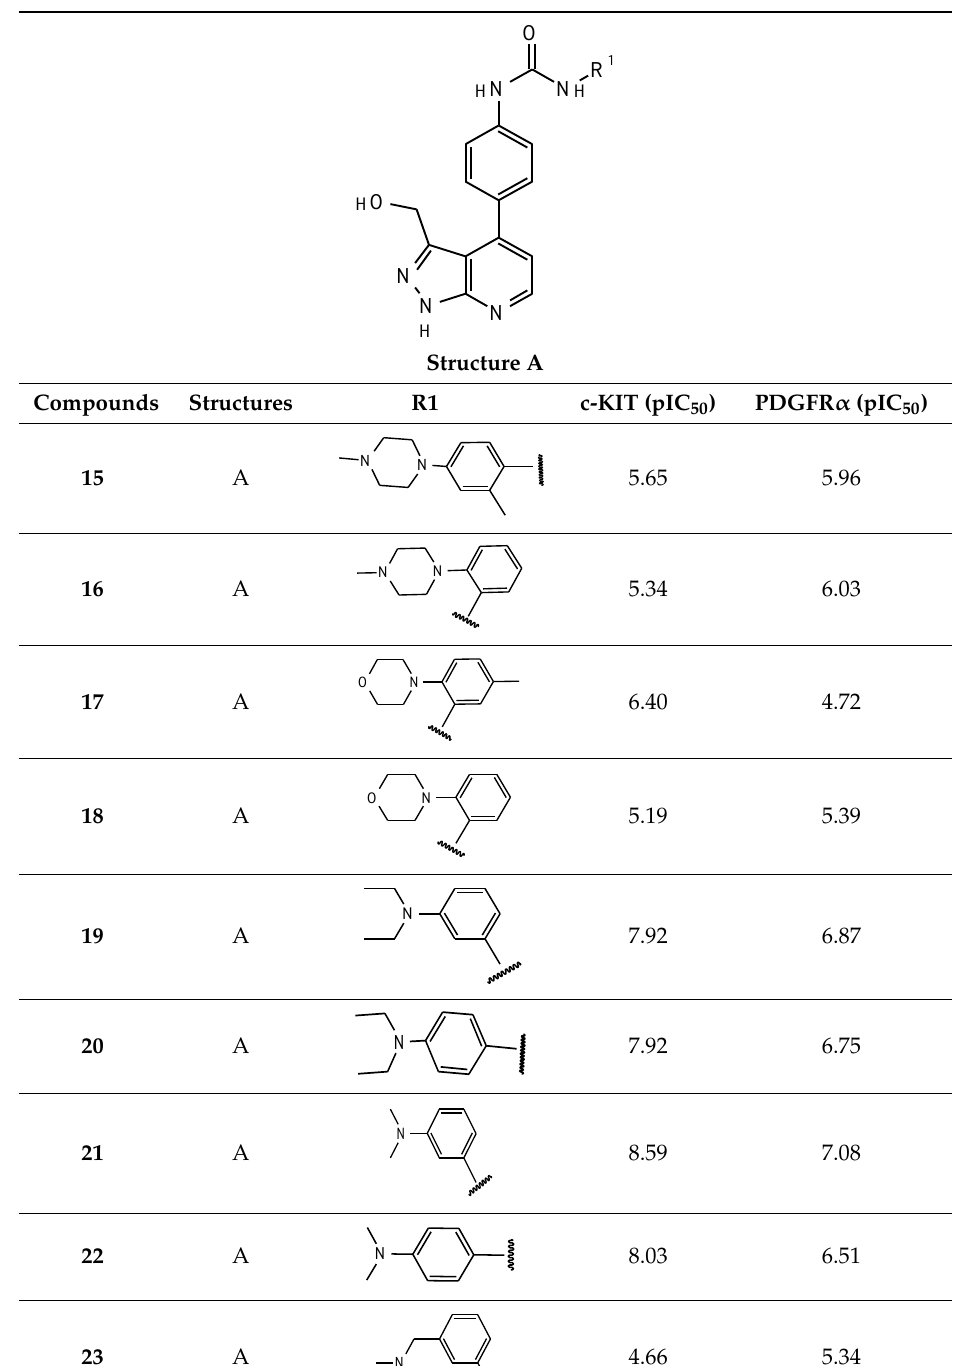
Table 1. Structure of the pyrazolopyridine derivatives and their pIC 50 values for stem cell factor receptor (c-KIT) and platelet-derived growth factor receptor alpha